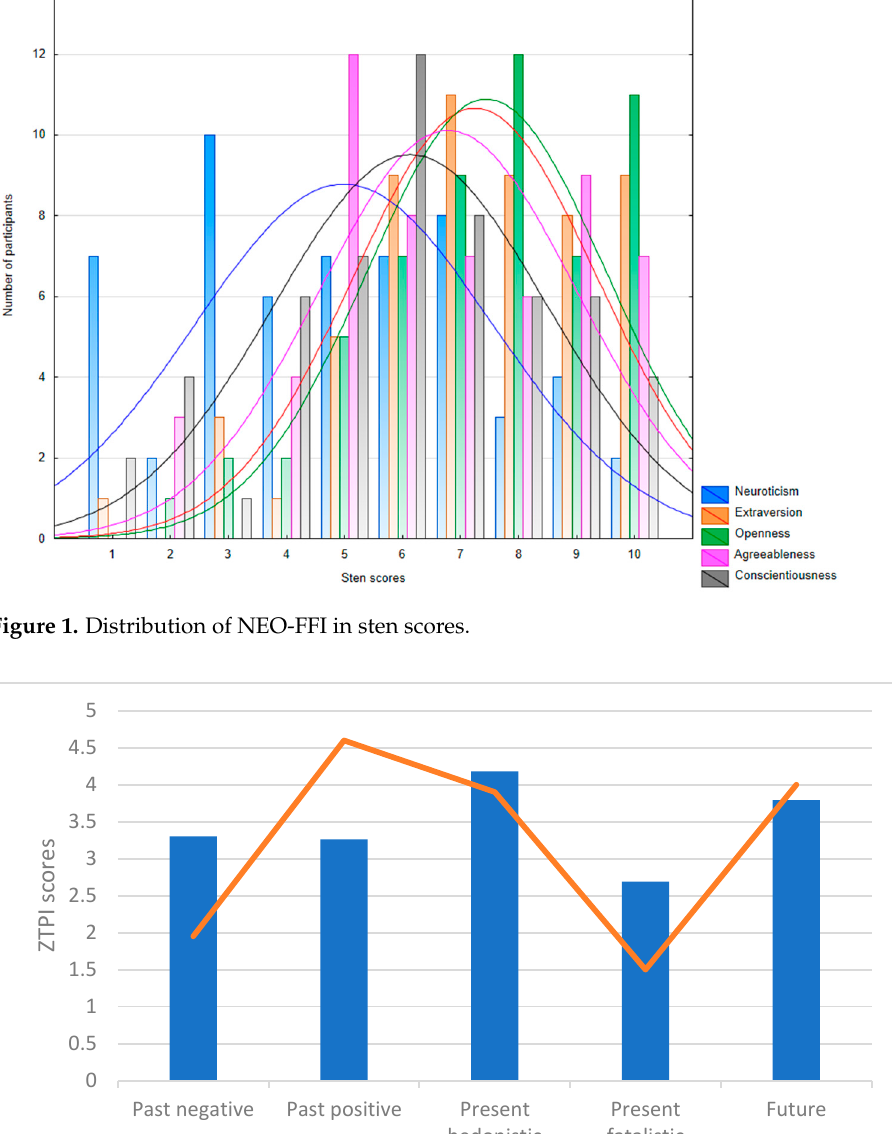
Figure 2. Comparison of Onco-Cruise participant ZTPI scores to Balanced Time Perspective.